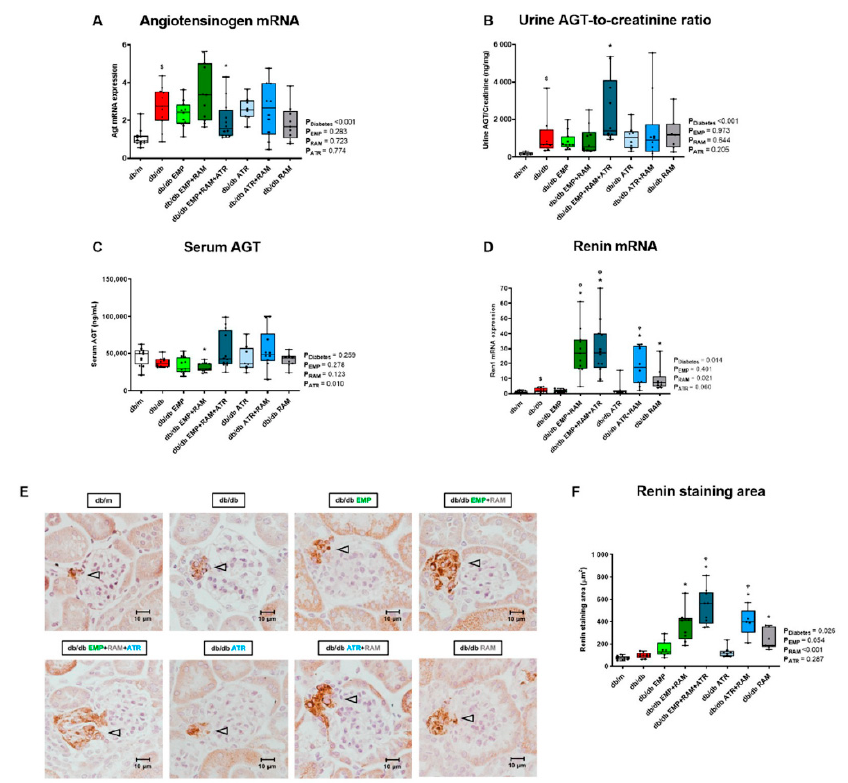
Figure 5. Kidney, urine, and serum angiotensinogen and renal renin levels in vehicle-treated db/m mice, vehicle-treated db/db mice, and db/db mice treated with empagliflozin, atrasentan, ramipril, or their combinations. ( A ) Angiotensinogen (AGT) mRNA expression. ( B ) Urine AGT-to- creatinine ratio. ( C ) Serum AGT values. ( D ) Renin mRNA expression. ( E ) Representative kidney sections showing specific renin staining ( × 400 magnification). Increased juxtaglomerular cell staining (grey arrows) is observed in treatments with ramipril and or ramipril combination with empagliflozin and/or atrasentan. ( F ) Renin stained area in µ m 2 . db/m : non-diabetic mice treated with vehicle. db/db : diabetic mice treated with vehicle. db/db EMP : diabetic mice treated with empagliflozin. db/db EMP + RAM : diabetic mice treated with empagliflozin and ramipril. db/db EMP + RAM + ATR : diabetic mice treated with empagliflozin, ramipril, and atrasentan. db/db ATR : diabetic mice treated with atrasentan. db/db ATR + RAM : diabetic mice treated with atrasentan and ramipril. db/db RAM : diabetic mice treated with ramipril. Factorial ANOVA main effect results are displayed next to the graph. P Diabetes : diabetes’ main effect. P EMP : empagliflozin’s main effect. P RAM : ramipril’s main effect. P ATR : atrasentan’s main effect. $ p < 0.05 vehicle-treated db/db mice vs. vehicle-treated db/m mice. * p < 0.05 any treated db/db mice compared with vehicle-treated db/db mice. φ p < 0.05 combinations of empagliflozin or atrasentan with ramipril db/db vs. ramipril db/db.